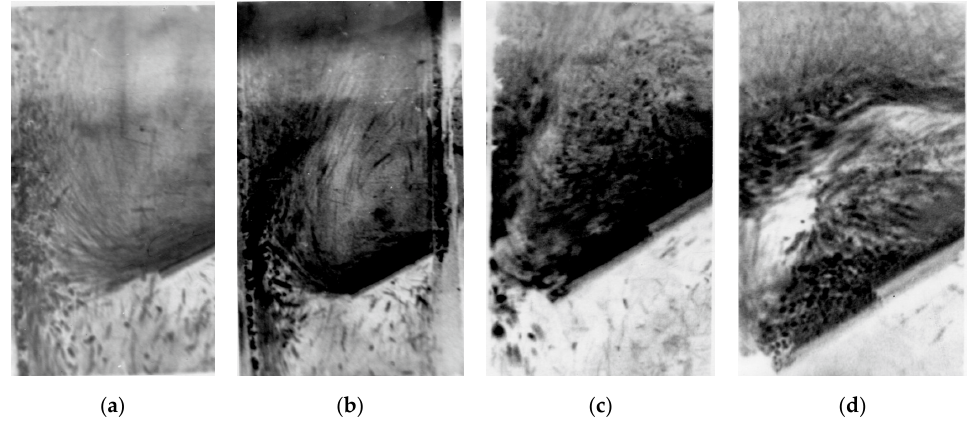
Figure 7. Photographic image of hydrodynamic modes: ( a ) “gravitationally falling layer” mode; ( b ) “transitional” mode; ( c ) “weighted layer” mode; ( d ) “piston” mode.